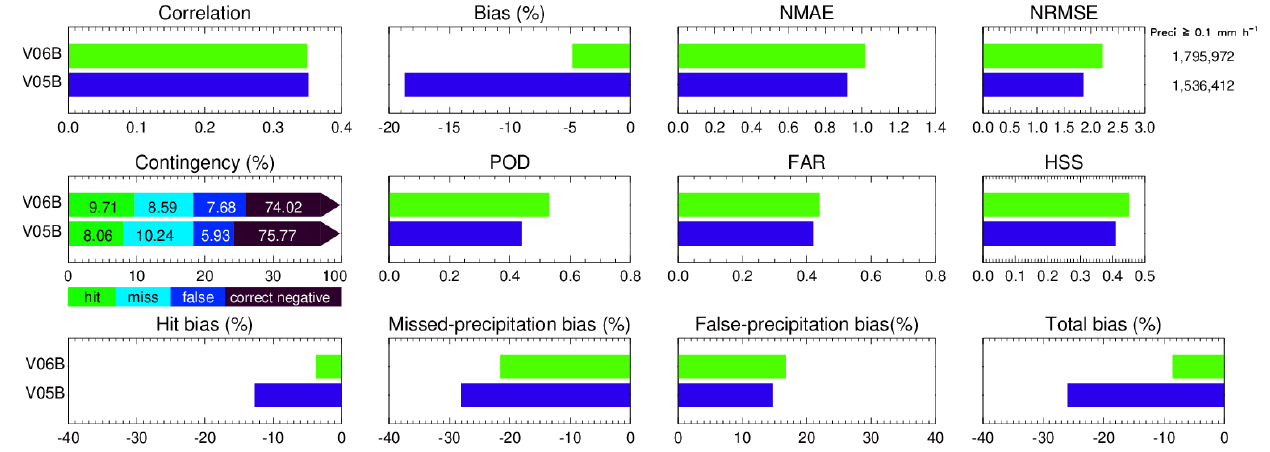
Figure 9. Same as Figure 5 but for IMERG V05B and V06B regardless of sources. To further investigate the distribution of precipitation occurrences by intensity, joint distri- butions of half-hourly precipitation rates at 0.1 ◦ resolution are constructed for IMERG V05B (Figure 10) and V06B (Figure 11) relative to KPOL, respectively, over the area with 100-km radius from KPOL during the entire study period. The precipitation threshold is again set to 0.1 mm h − 1 . The black dotted line overlayed on each panel of Figures 10 and 11 is the quantile–quantile (Q-Q) plot, which indicates deviations from the one-to-one line at different quantiles. The numbers on the bottom right are the sample sizes (number of hits), ratio (IMERG/KPOL), and correlation for all matched IMERG and KPOL precipitation